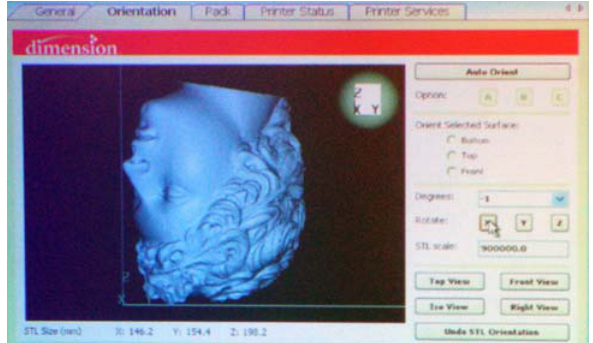
Figure 6. Orientation of the model